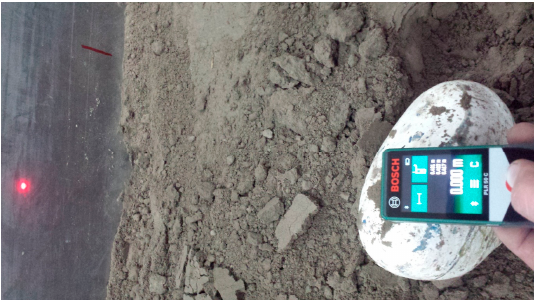
Figure 7. Measurement of the final position of the stone using the Bosch PLR 50C laser rangefinder.